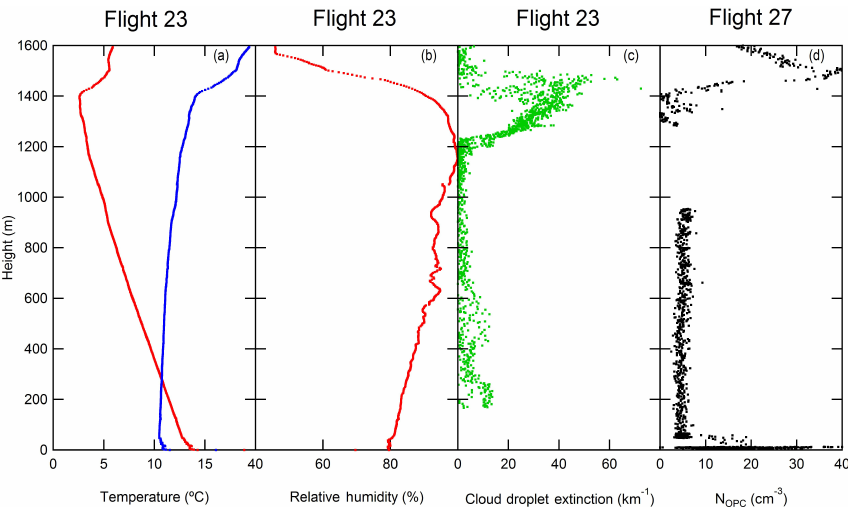
Figure 7. Vertical profiles of temperature, virtual potential temperature ( θ v ), relative humidity, cloud droplet extinction and OPC total aerosol concentration. The figure consists of measurements collected from flights 23 and 27 on 11 August 2015 at 12:00–12:47 and 16:58–17:33, respectively. The cloud level is 1200–1480m in flight 23 and lowered to approximately 980–1280m in flight 27. OPC measurements that occurred in the cloud have been